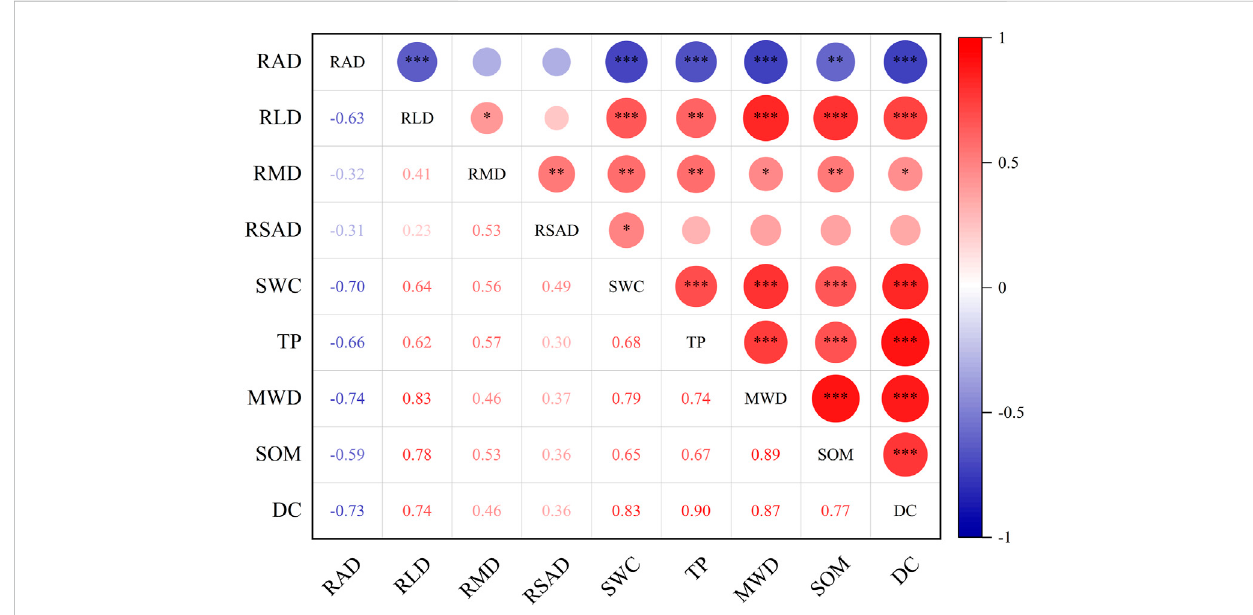
FIGURE 5 Pearson ’ s correlation analysis of correlations between root and soil properties. RAD, root average diameter; RLD, root length density; RMD, root massdensity;RSAD,rootsurfaceareadensity;SWC,soilmoisturecontent;TP,totalporosity;MWD,meanweightdiameter;SOM,soilorganicmatter;DC, dye-tracing coverage. Blue and red indicate positive and negative correlations at signi fi cance levels of * p < 0.05, ** p < 0.01, and *** p <